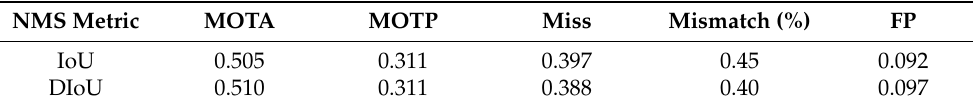
Table 3. Comparison of the tracking results for pedestrian objects using different NMS metrics on the validation set of Waymo Open Dataset.